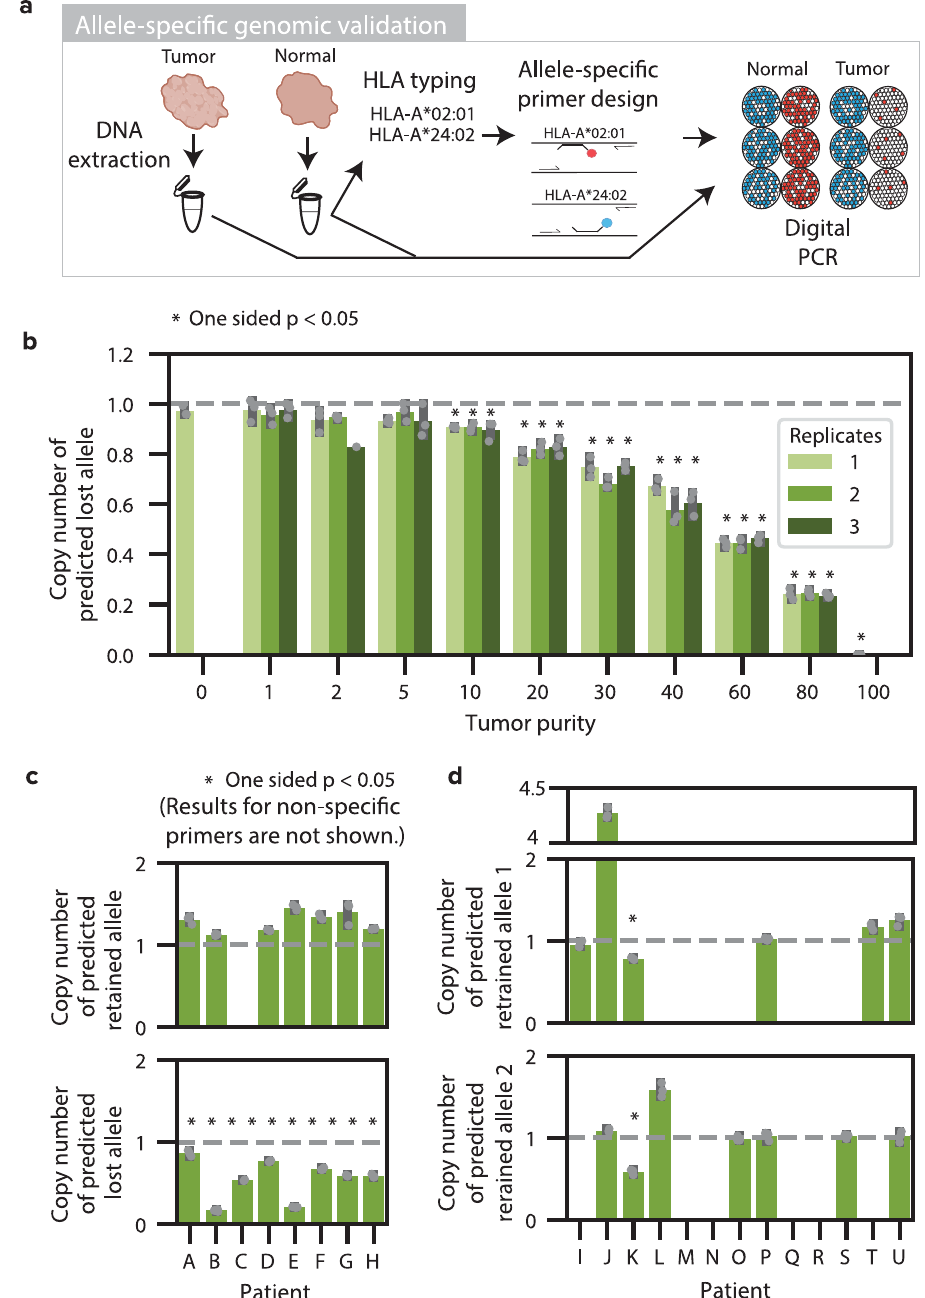
Fig. 3 Allele-speci fi c genomic validation with digital PCR. a Allele-speci fi c genomic validation was performed using paired tumor and adjacent normal fresh frozen samples. DNA was extracted from each sample. Allele-speci fi c primers were designed speci fi cally for each patient. Digital PCR was performed on each sample to orthogonally determine the allele-speci fi c copy number. b Bar plot showing the allele-speci fi c copy number of the predicted lost allele, relative to RNase P , as measured by dPCR for cell line mixtures of 11 varying tumor purities, with n = 3 technical replicates examined over three independent experiments per tumor purity (tumor purity 2 replicate 3 only had 1 independent experiment; tumor purity 0 and 100 only have 1 technical replicate). The dashed line denotes the expected value for no change in copy number. Asterisks denote a statistically signi fi cant difference ( p < 0.05) from the copy number in the normal sample with a one-sided Student T test. c Bar plots denoting the HLA allele dPCR copy number relative to the multiplexed RNase P for 8 patient tumor samples with n = 3 technical replicates. The alleles predicted by DASH to be retained are shown on the top plot while the alleles predicted to be deleted are shown on the bottom plot. The dashed gray lines denote the expected copy number of one if there are no copy number alterations. Asterisks denote samples with p -values < 0.05 as determined by a one-sided Student T test. d Bar plots showing the HLA allele dPCR copy number relative to the multiplexed RNAse P for 13 patient tumor samples where both alleles were predicted to be retained with n = 3 technical replicates. Asterisks denote samples with p -values < 0.05 as determined by a one-sided Student T test. 95% con fi dence intervals are shown in gray. Source data and exact p values are provided with this paper in the Source Data fi le.